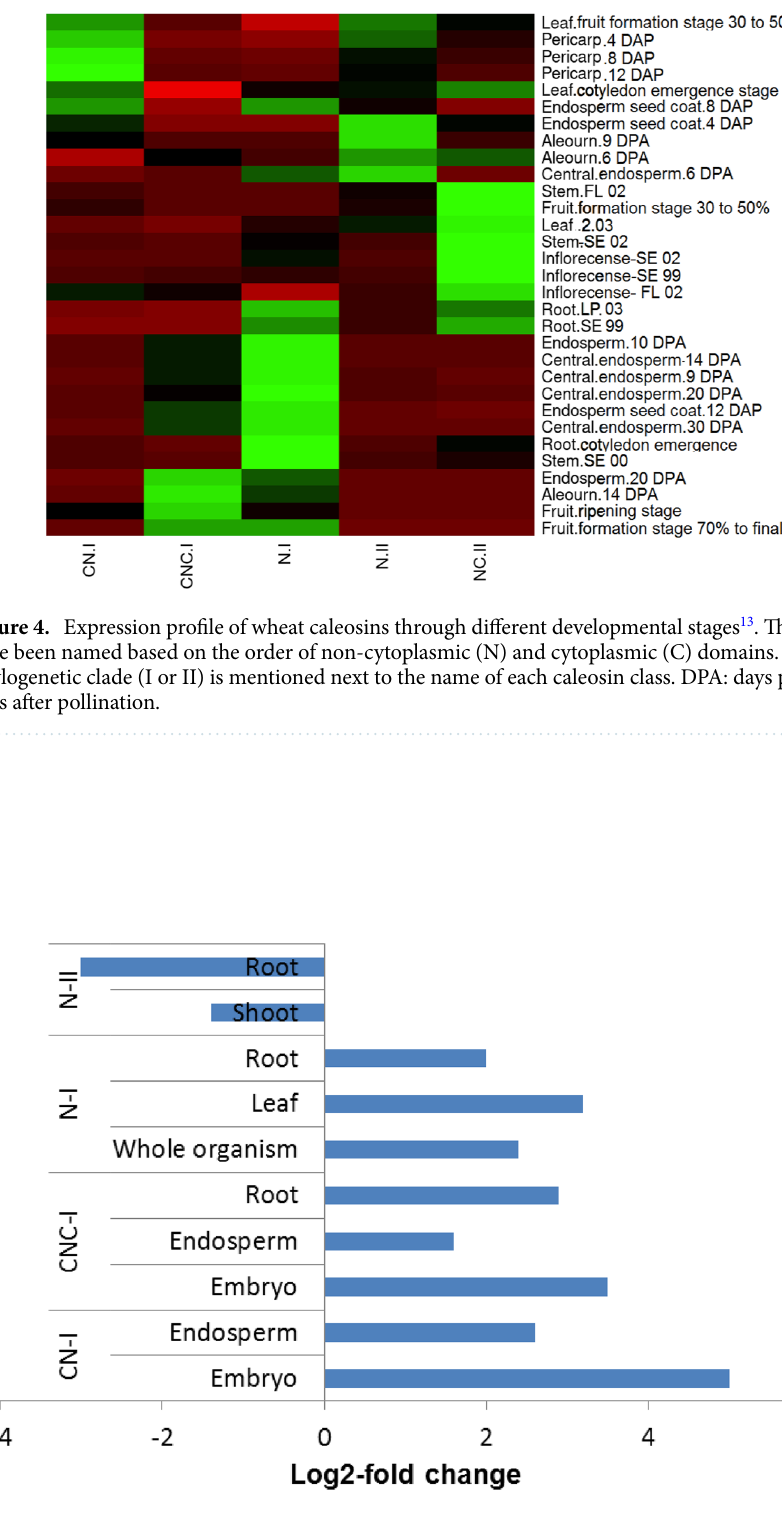
Figure 5. The differential expression of caleosins in response to 20 Mm abscisic acid. The data was extracted from the Expression Atlas database. The caleosin classes have been named based on the order of non- cytoplasmic (N) and cytoplasmic (C) domains. Moreover, the phylogenetic clade (I or II) is mentioned next to the name of each caleosin